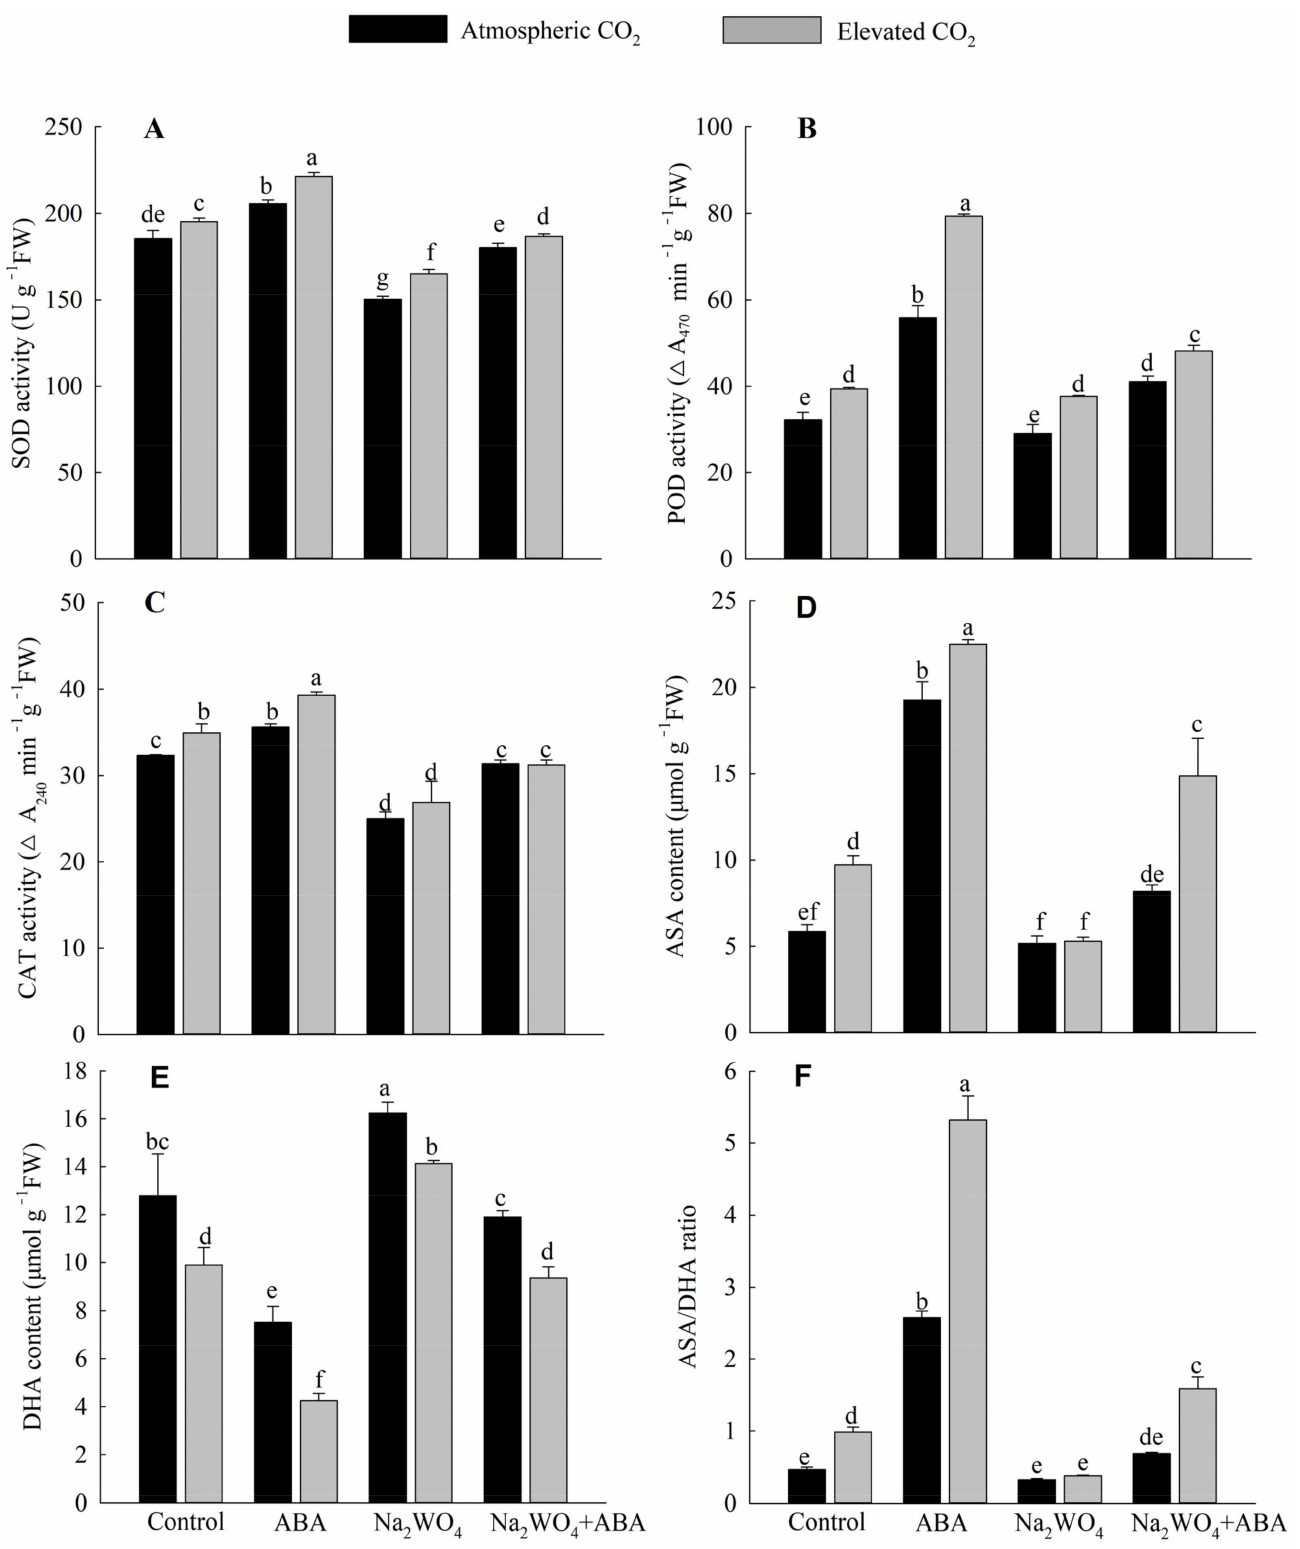
Figure 5. Effects of elevated CO 2 and exogenous ABA on SOD activity ( A ), POD activity ( B ), CAT activity ( C ), ASA content ( D ), DHA content ( E ), and ASA/DHA ratio ( F ) in leaves of cucumber seedlings under drought stress. Different lowercase letters represent significant differences between treatments at the 0.05 level. Values were the means ± SD (n =